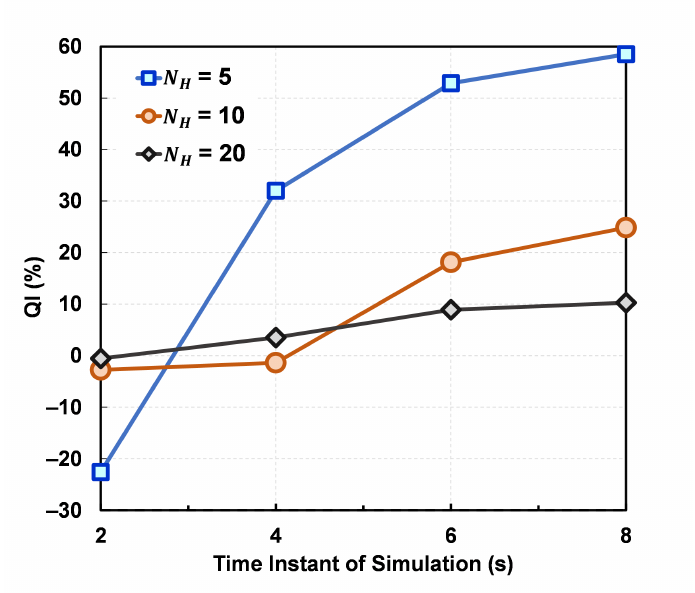
Figure 15. Quality improvement (QI) compared for the three N H values. N opt = 5 has been chosen for all optimization exercises.